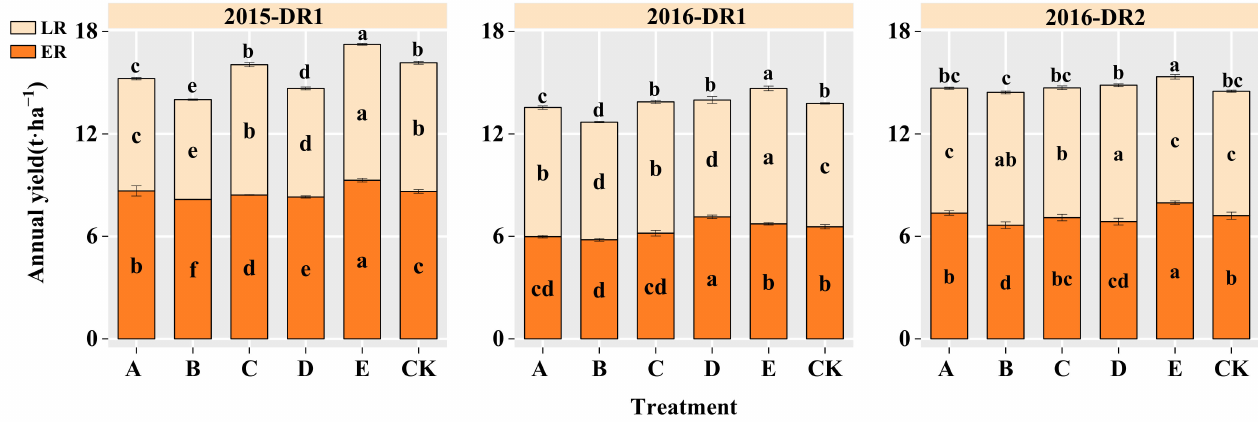
Figure 1. The annual yield in a double-cropping rice system. Annual yield is the sum of early- and late-season rice yields. The data are presented as mean ( ± standard error). Different lowercase letters indicate significant differences between different treatments in a double-cropping system at p < 0.05.